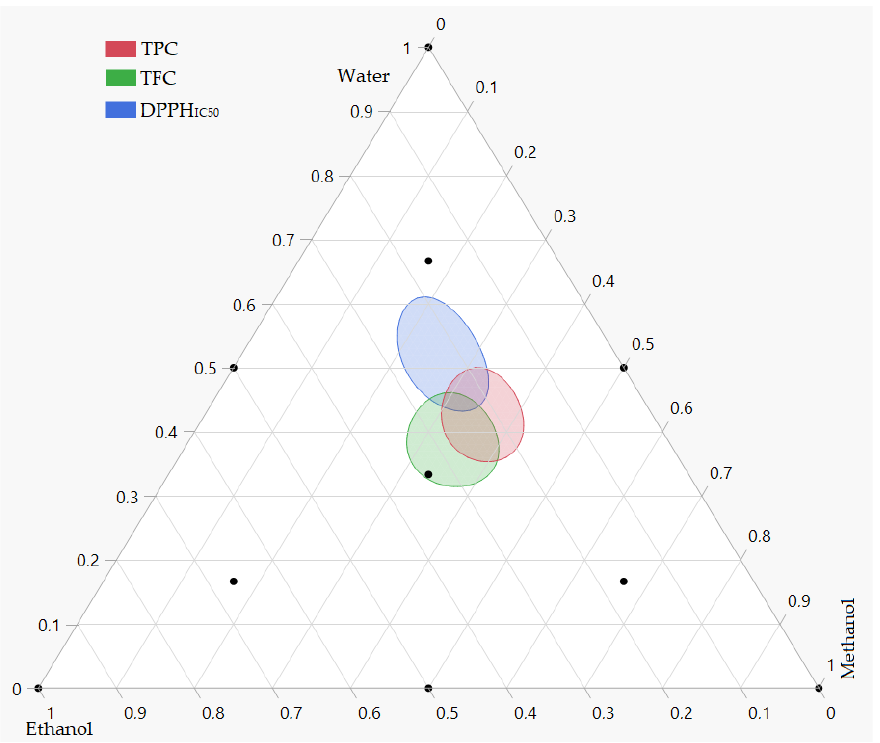
Figure 7. Mixture contour plot illustrating the simultaneous optimization of the three responses based on the values given by desirability functions.